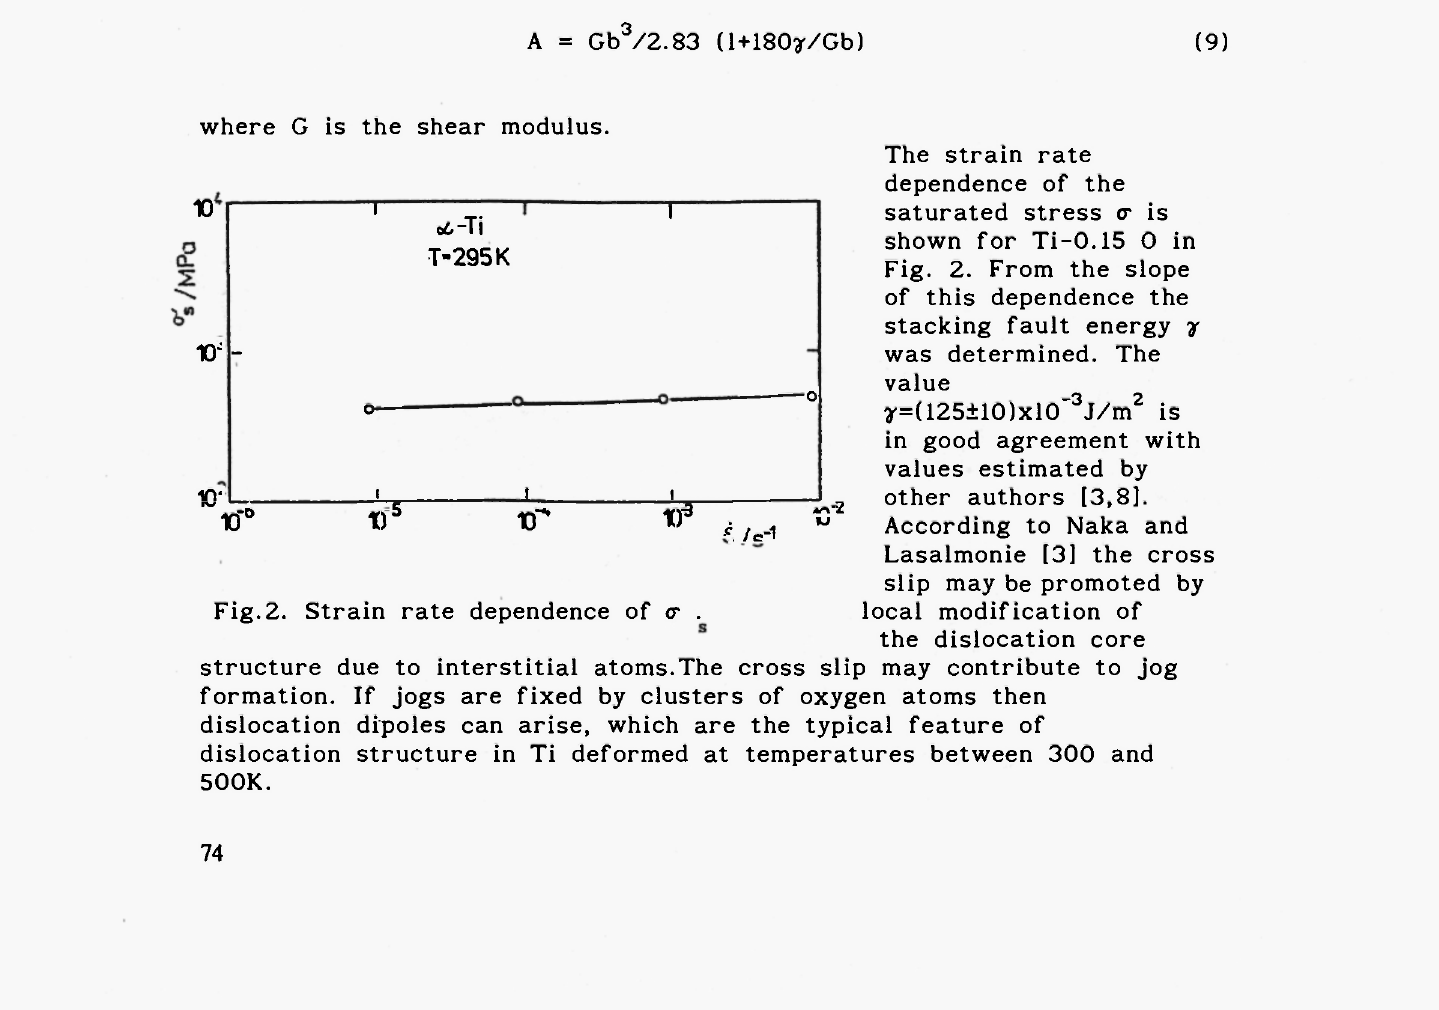
Fig. 2. From the slope of this dependence the stacking fault energy γ was determined. The